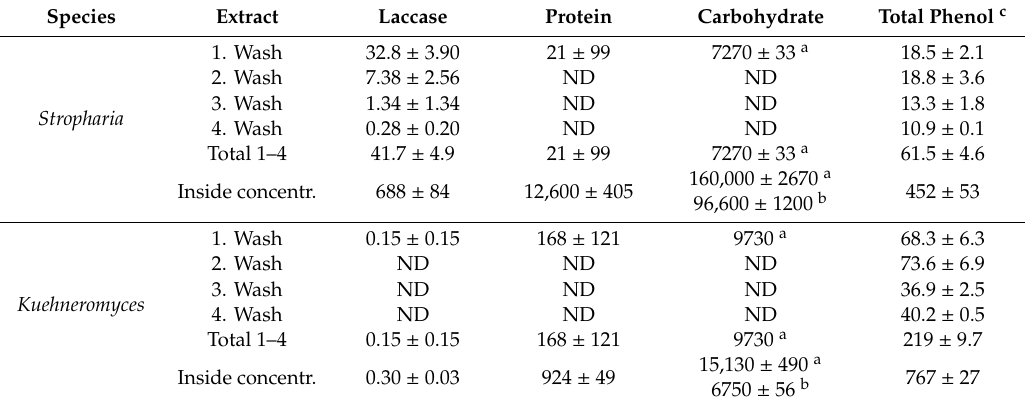
Table 2. Laccase activity ( µ mol ABTS • + kg − 1 min − 1 ± SD), and the concentrations of